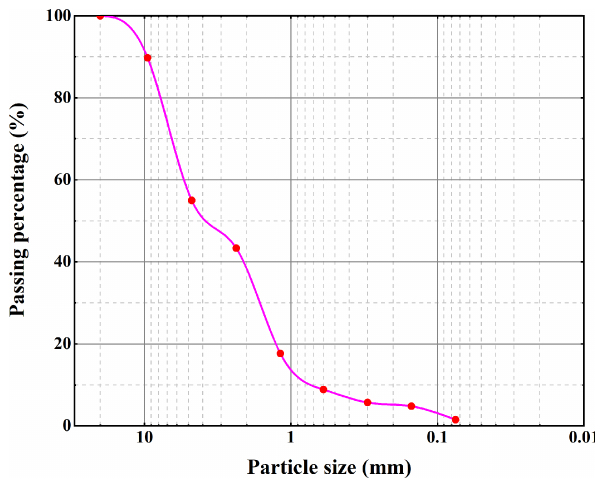
/H d and V 1 / 3 /H d both range from 1 to d l